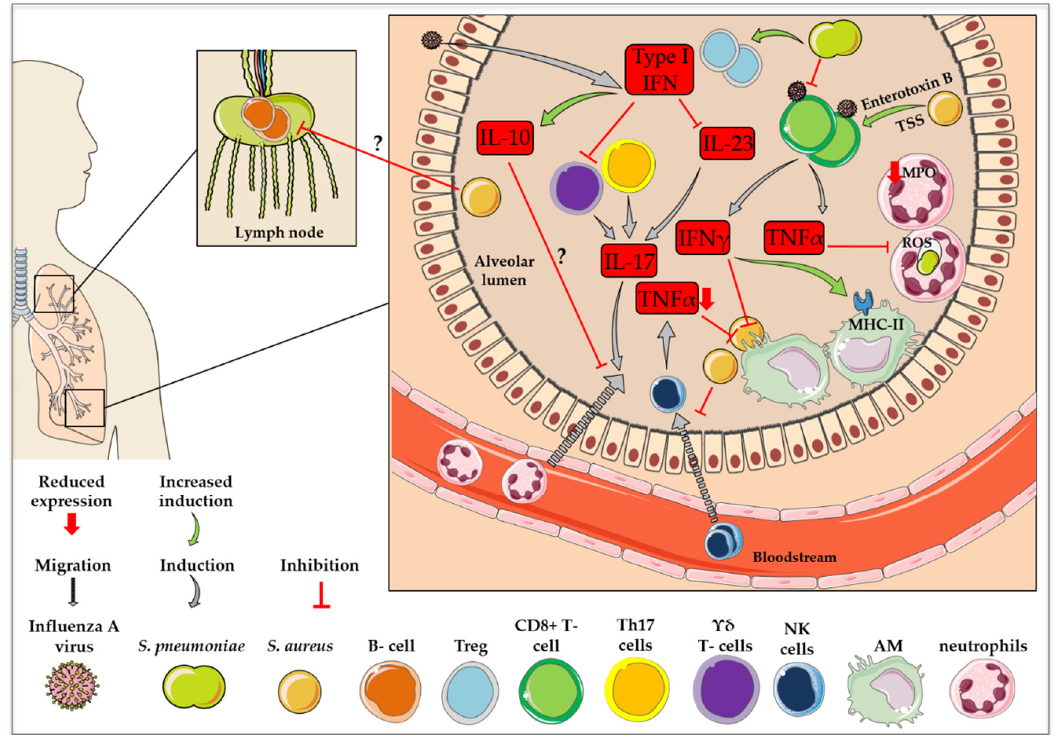
Figure 3. Changes in immune cell recruitment and activation in influenza virus co-infection with S. pneumoniae or S. aureus . This figure was created using Servier Medical Art templates, which are licensed under a Creative Commons Attribution 3.0 Unported License; https://smart.servier.com (accessed on 11 February 2021). Unported License; https://smart.servier.com (accessed on 11 February